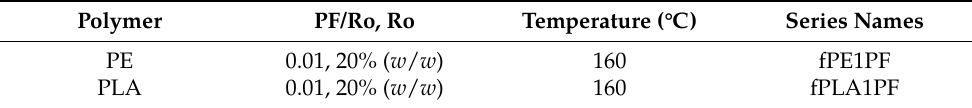
Table 3. Processing parameters for melt-spinning of surfactant (PF) containing blends.